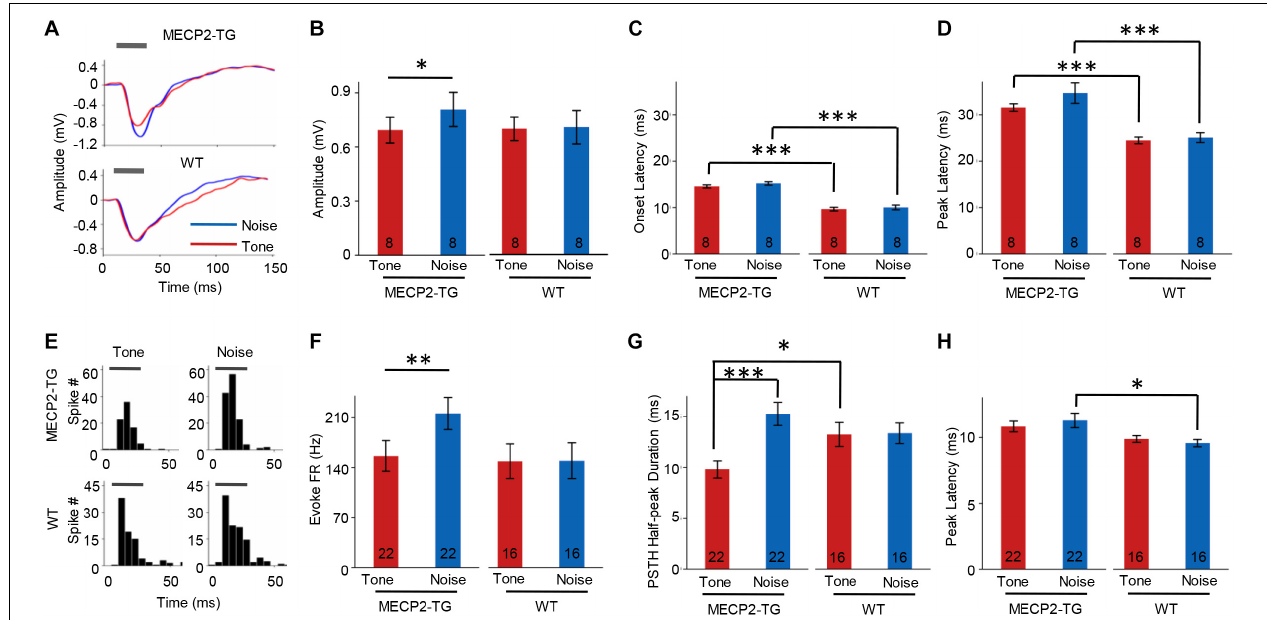
FIGURE 6 | (A) Representative traces of local field potentials (LFPs) recorded from MECP2-TG and wild-type (WT) mice. The gray bar indicates the occurrence of stimuli (red line: tone stimulus; blue line: noise stimulus). (B) Averaged amplitude of LFPs recorded from MECP2-TG mice and WT mice. ∗ p < 0.05, paired t -test, mean ± standard error of the mean (SEM; red: tone stimulus; blue: noise stimulus). (C) Averaged onset latency of LFPs recorded from MECP2-TG mice and WT mice. ∗∗∗ p < 0.001, t -test, mean ± SEM (red: tone stimulus; blue: noise stimulus). (D) Averaged peak latency of LFPs recorded from MECP2-TG mice and WT mice. ∗∗∗ p < 0.001, t -test, mean ± SEM (red: tone stimulus; blue: noise stimulus). (E) Representative peri-stimulus spike timing histograms (PSTHs) in response to different stimulation. The gray bar indicates the occurrence of stimuli. (F) Averaged multiunit activity in response to different stimulation. ∗∗ p < 0.01, t -test, mean ± SEM (red: tone stimulus; blue: noise stimulus). (G) Averaged half-peak durations on PSTHs recorded from MECP2-TG mice and WT mice. ∗ p < 0.05, t -test, ∗∗∗ p < 0.001, paired t -test, mean ± SEM (red: tone stimulus; blue: noise stimulus). (H) Averaged peak latency of PSTHs recorded from MECP2-TG mice and WT mice. ∗ p < 0.05, t -test, mean ± SEM (red: tone stimulus; blue: noise stimulus).